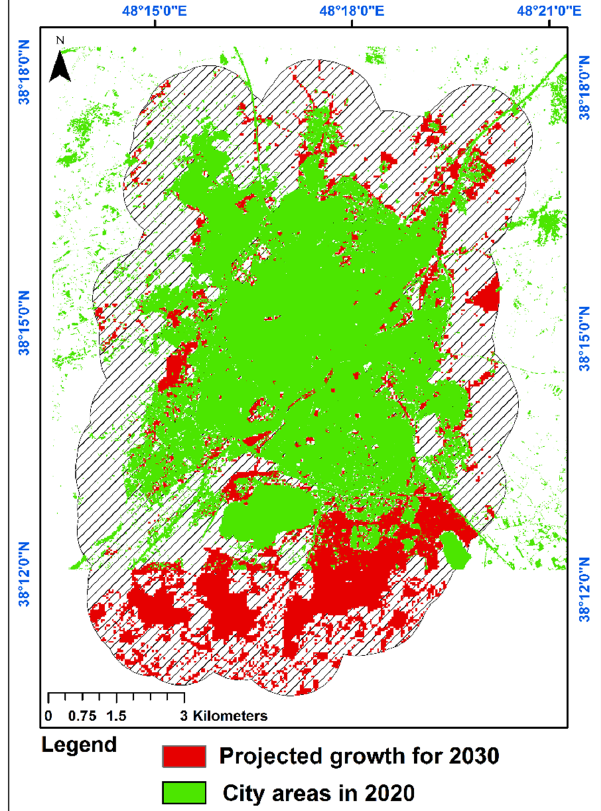
Figure 9. Changes in built-up areas of Ardabil in 2030 compared to 2020.